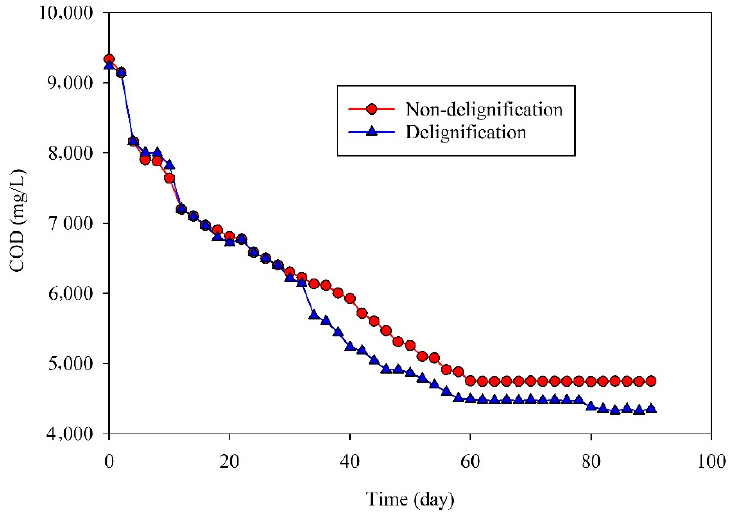
Figure 10. Effect of different pretreatments on the chemical oxygen demand (COD) reduction of 25% total solids (TS) C/N 25 (g/g).